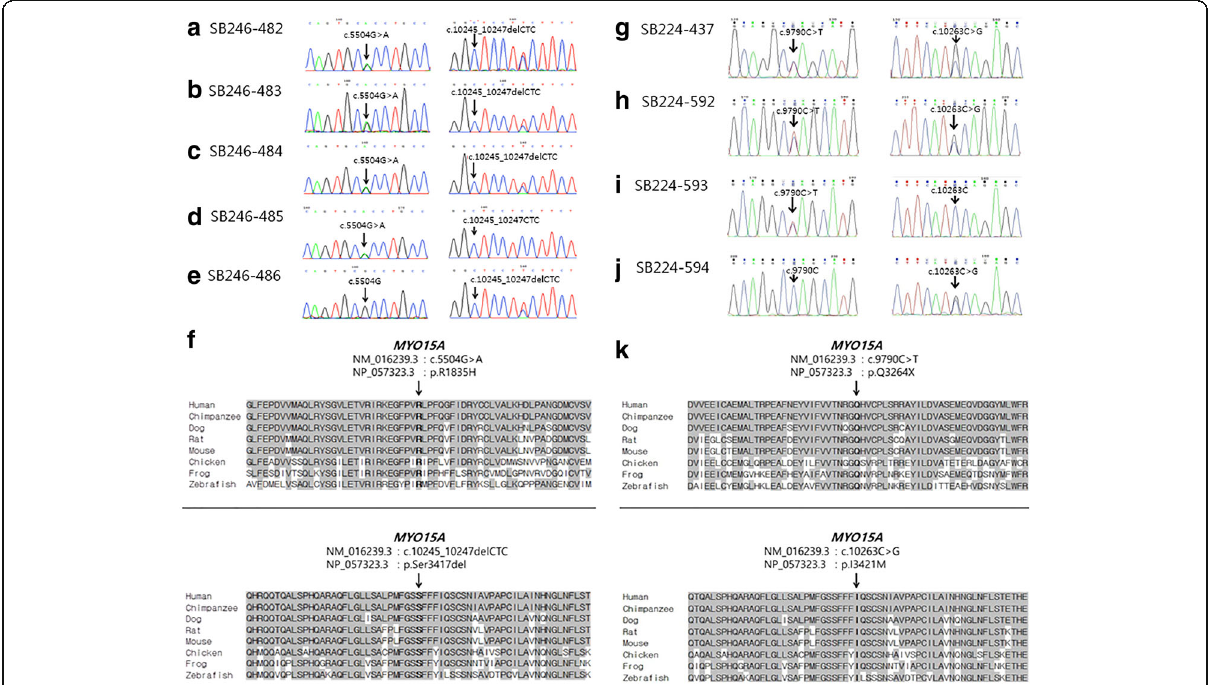
Fig. 4 Segregation of MYO15A variants in two families, SB246 and 224. a - c Sanger sequencing traces for c.5504G>A